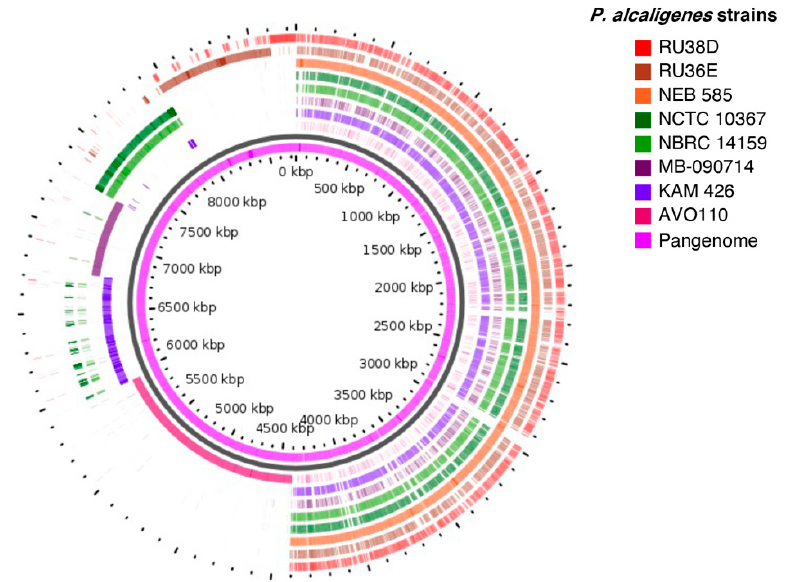
Figure 2. Circular plots of P. alcaligenes subgroup I genomes. Genome sequences were subjected to pan-genome analysis using the GView server. Innermost slot (purple) shows constructed pan-genome. White space indicates a region missing in the specified genome.